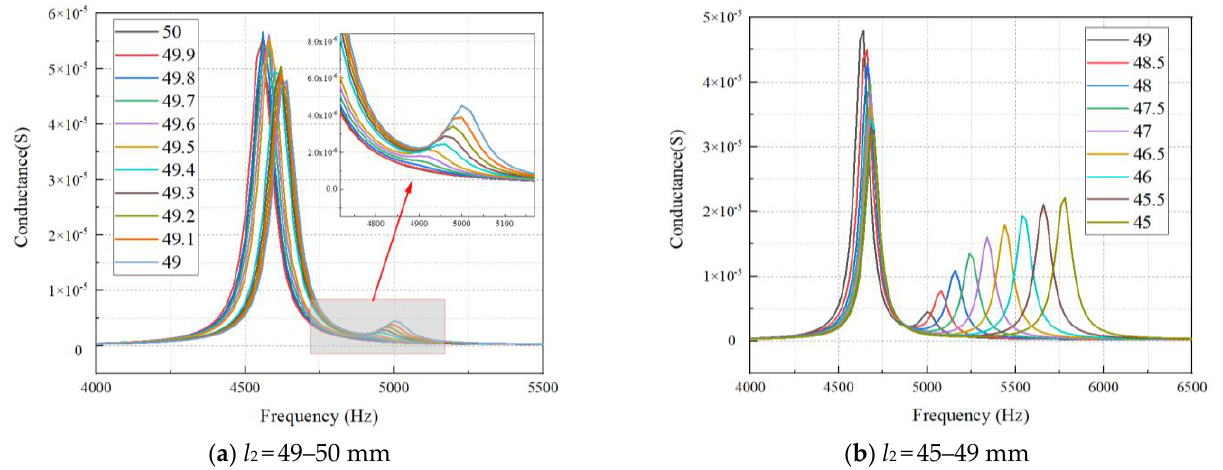
Figure 5. Conductance curve with different l 2 ( l 1 = 50 mm).